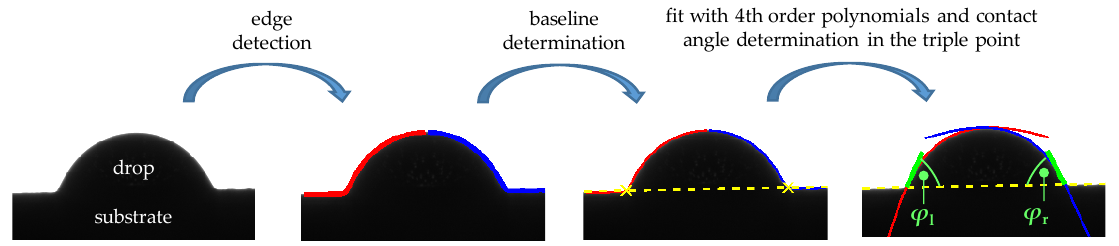
apex, 4th-order polynomial) and baseline determination (non-wetted substrate surface on the left and right of the drop), the contact angle was determined at the triple point. This apparent macroscopic contact angle was determined by neglecting surface heterogeneity and roughness. Contact angle measurement was done 3 times for each combination of polymer and substrate temperature.